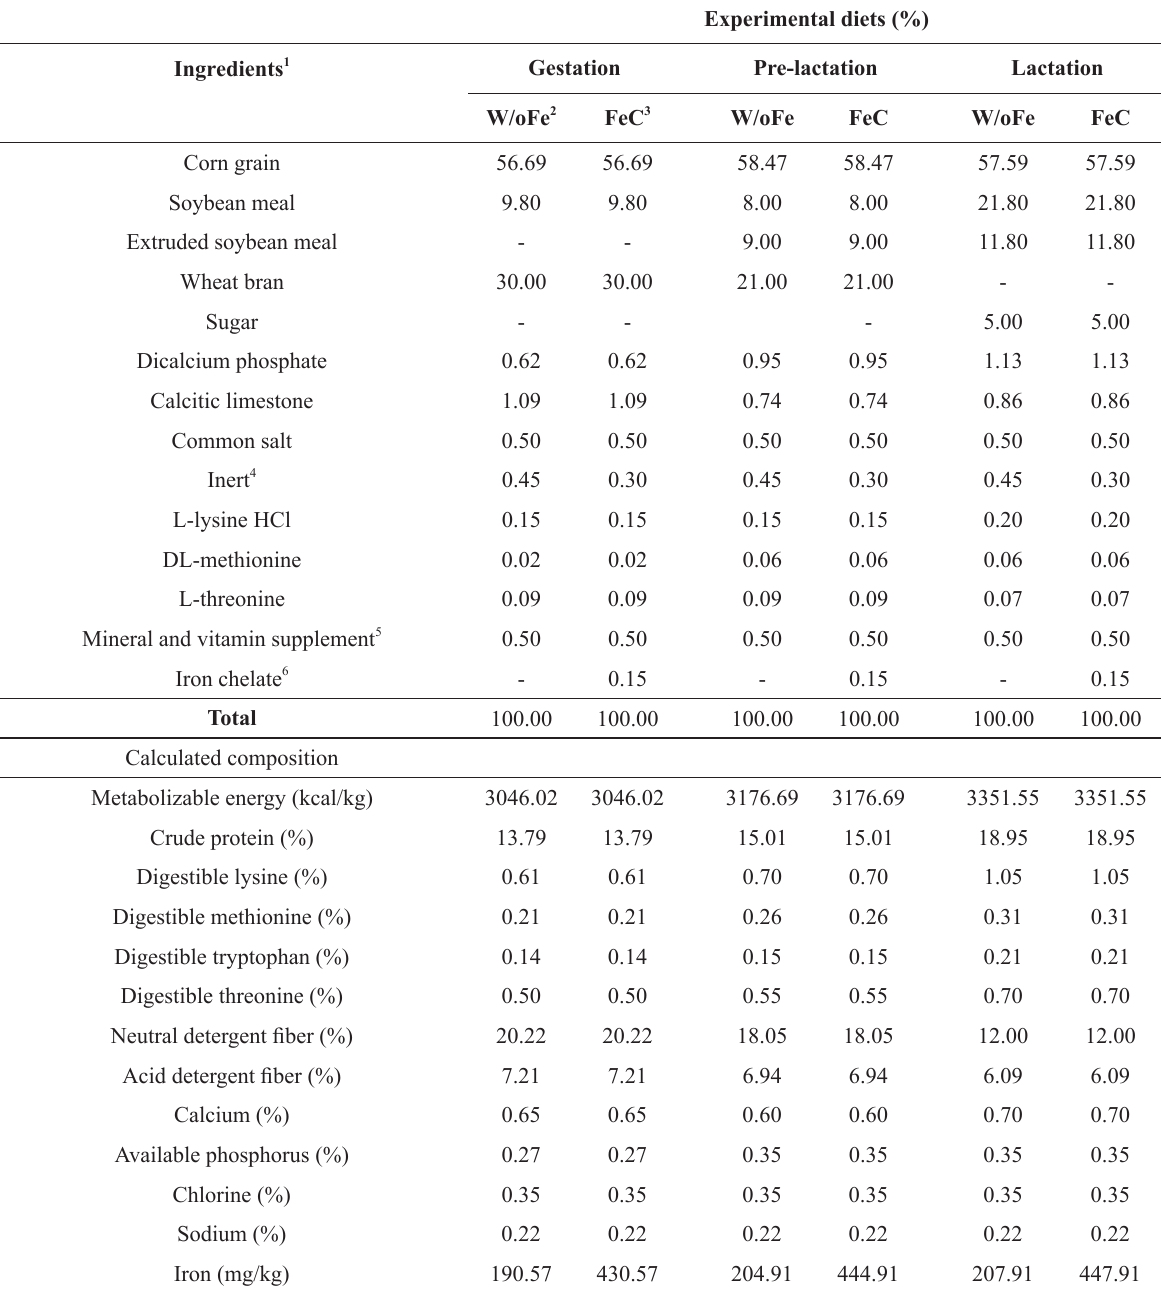
Composition, nutritional and energy content of experimental diets at gestation, pre-lactation and lactation phases of sows supplemented or not with iron